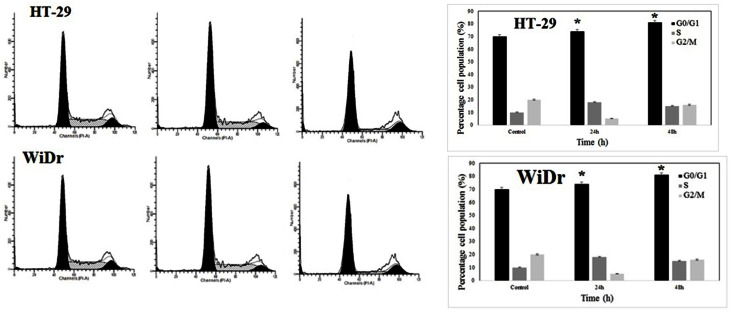
Effect of NTC on development of cell cycle using flow cytometry. Momentous cell cycle arrest was identified at G1 phase after 24 and 48 h incubation of the cells with NTC. All data were expressed as the means ± standard error of triplicate measurements. *P < 0.05 compared with the no-treatment group.